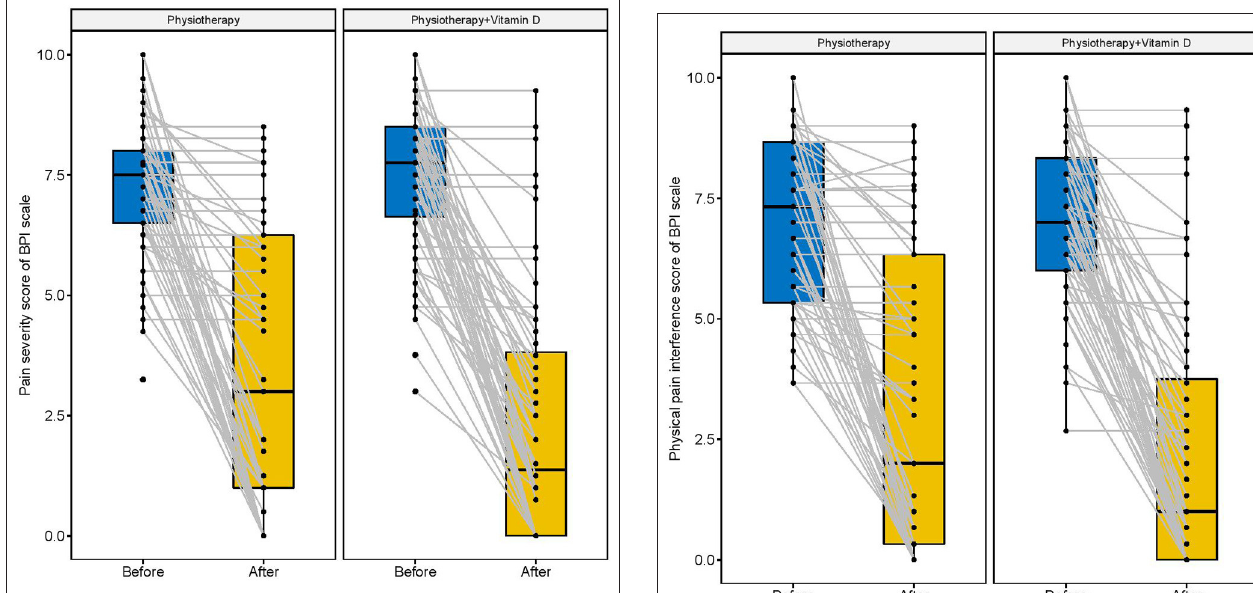
FIGURE 2 | Pain intensity scores before and after intervention among both groups.